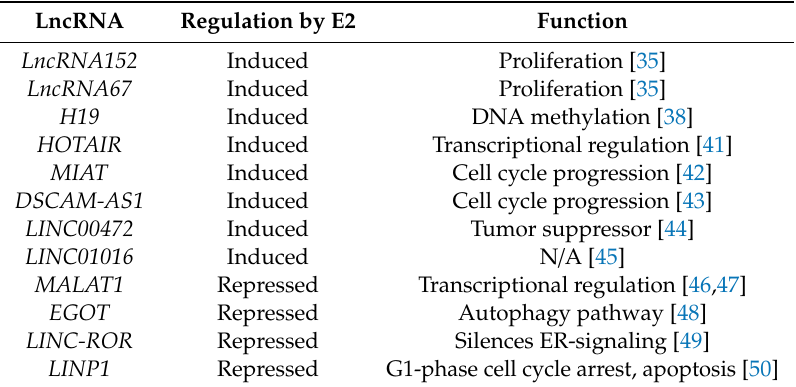
Figure 4. Known long non-coding RNA (lncRNA) mechanisms of action in regulating estrogen-dependent transcription. (TF: transcription factor; ER α estrogen receptor alpha; ERE: estrogen response element). Table 2. Estrogen-regulated lncRNAs.